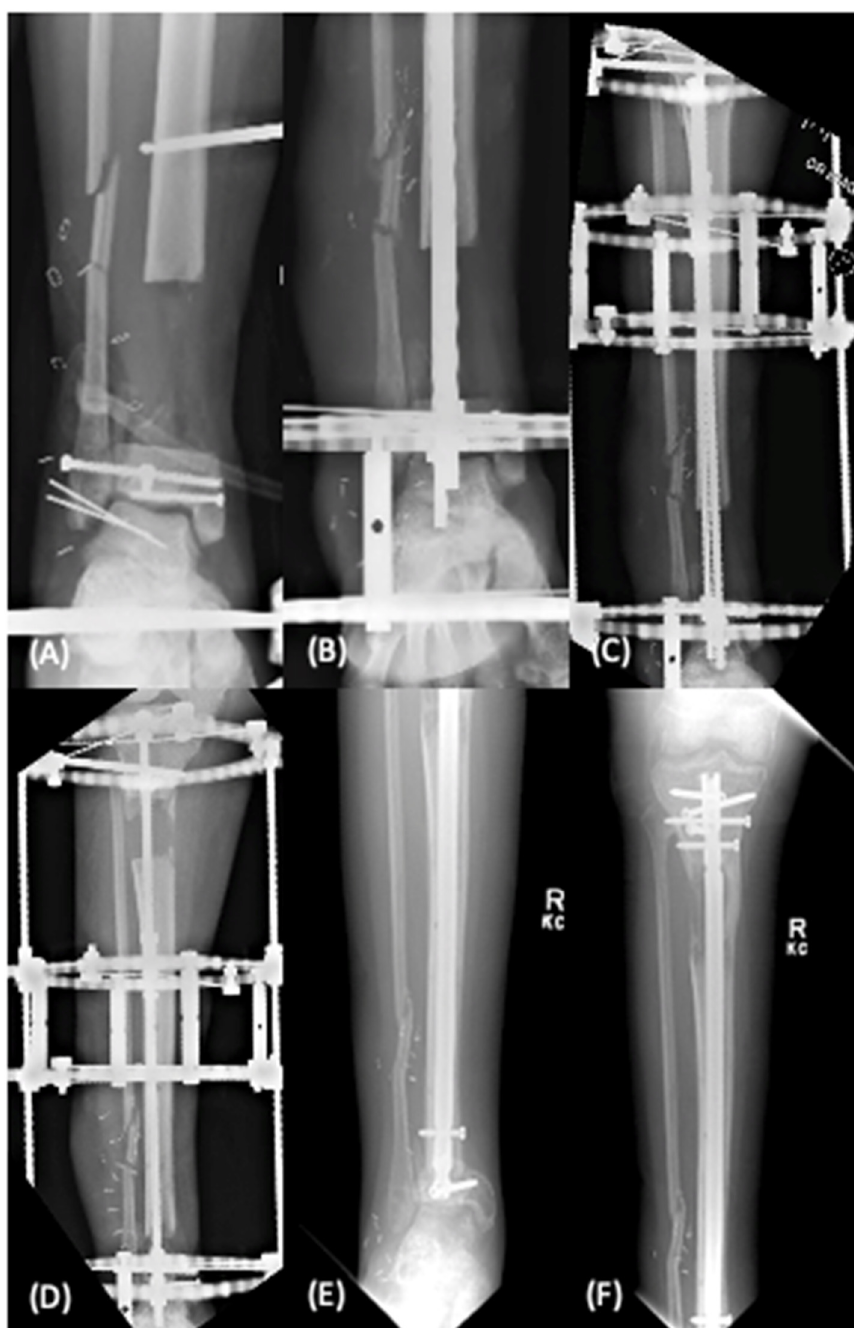
Figure 2. Distraction osteogenesis for the management of distal tibial metadiaphyseal defect